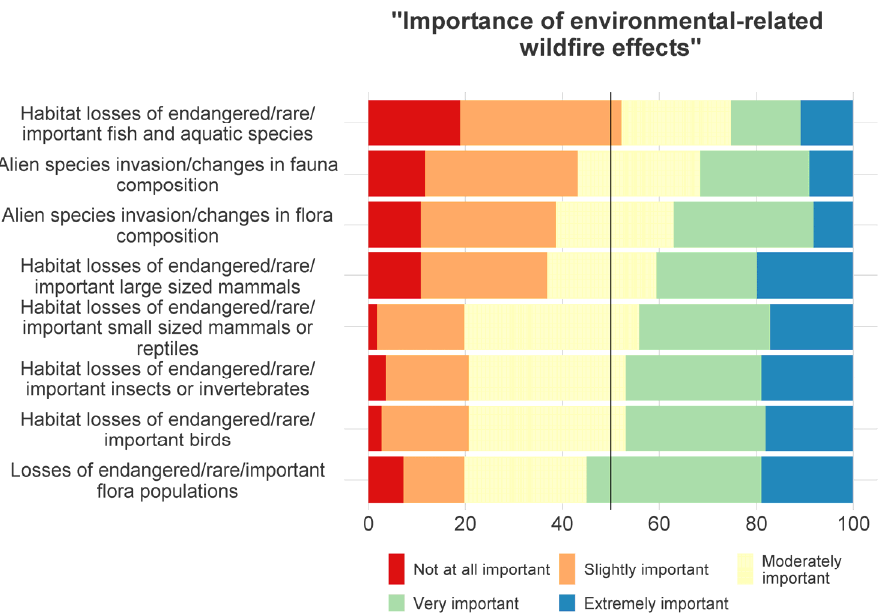
Figure 6. Likert scale rating of factors that negatively affect habitat or endangered/rare/important species population within areas burned by wildfire, as a percentage of survey responses.